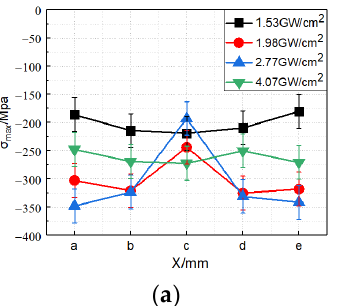
Figure 5. Equivalent stress nephograms of E690 high-strength steel model under different power